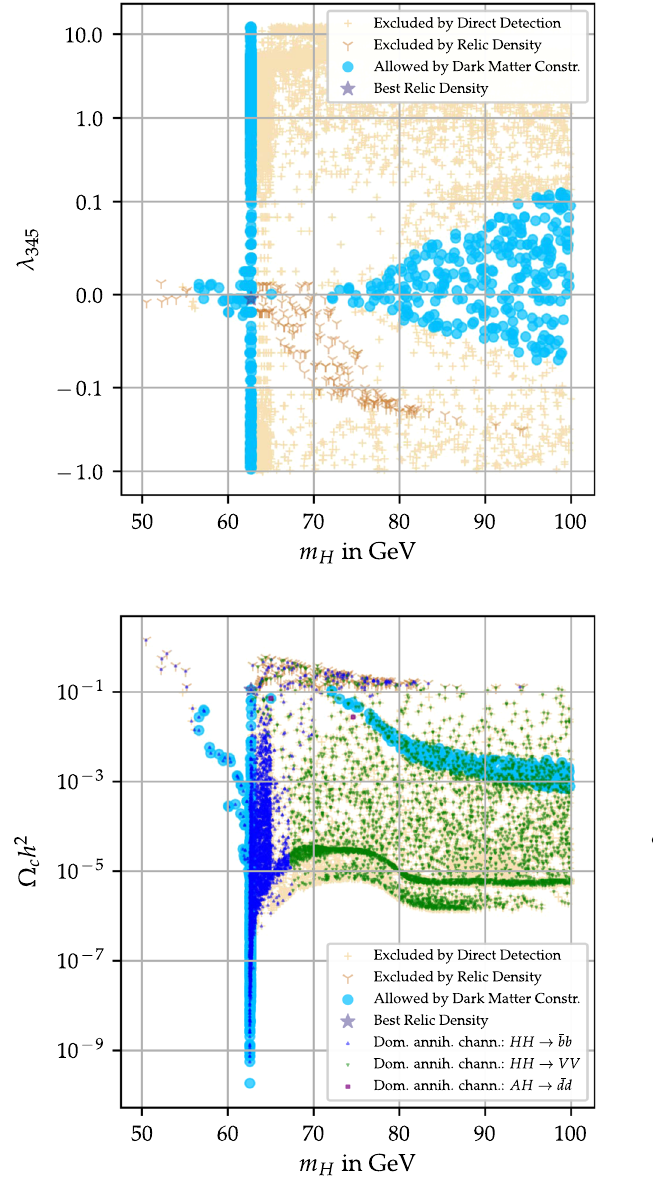
Fig. 3 Parameter space after including dark matter relic density and direct detection constraints. Top:allowed and forbidden regions in the ( m , λ ) plane. Bottom: Constraints in the ( m H 345 the bottom plot, we also show the dominant annihilation cross section foreachparameterpoint.The“BestRelicDensity”pointyields Ω c h 2 = 0 . 1141 which is the closest to the nominal Planck value, c.f. Eq. (18), out of all tested points